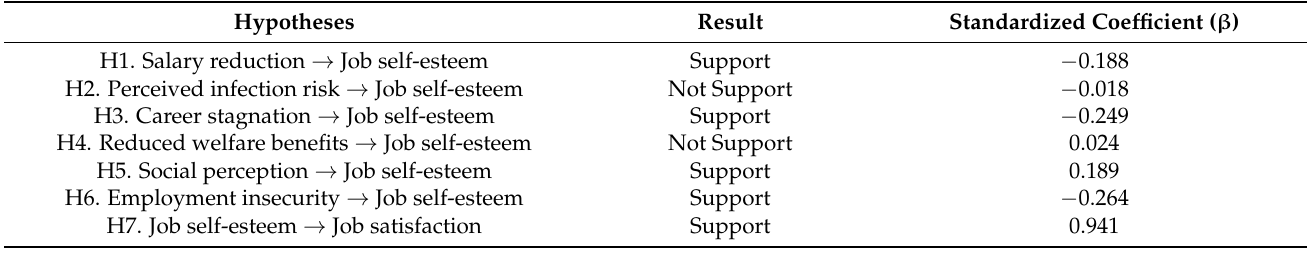
Table 10. Summary of research model verification result.